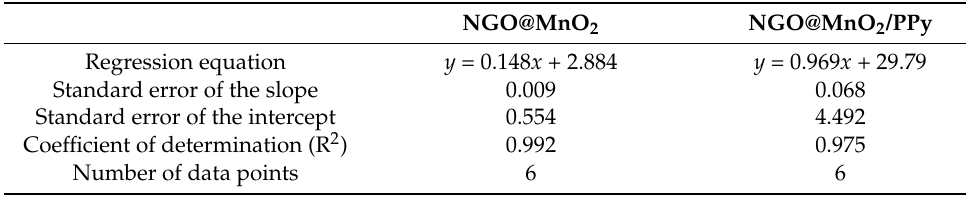
Table 1. Data of the calibration curve for the QCM sensor